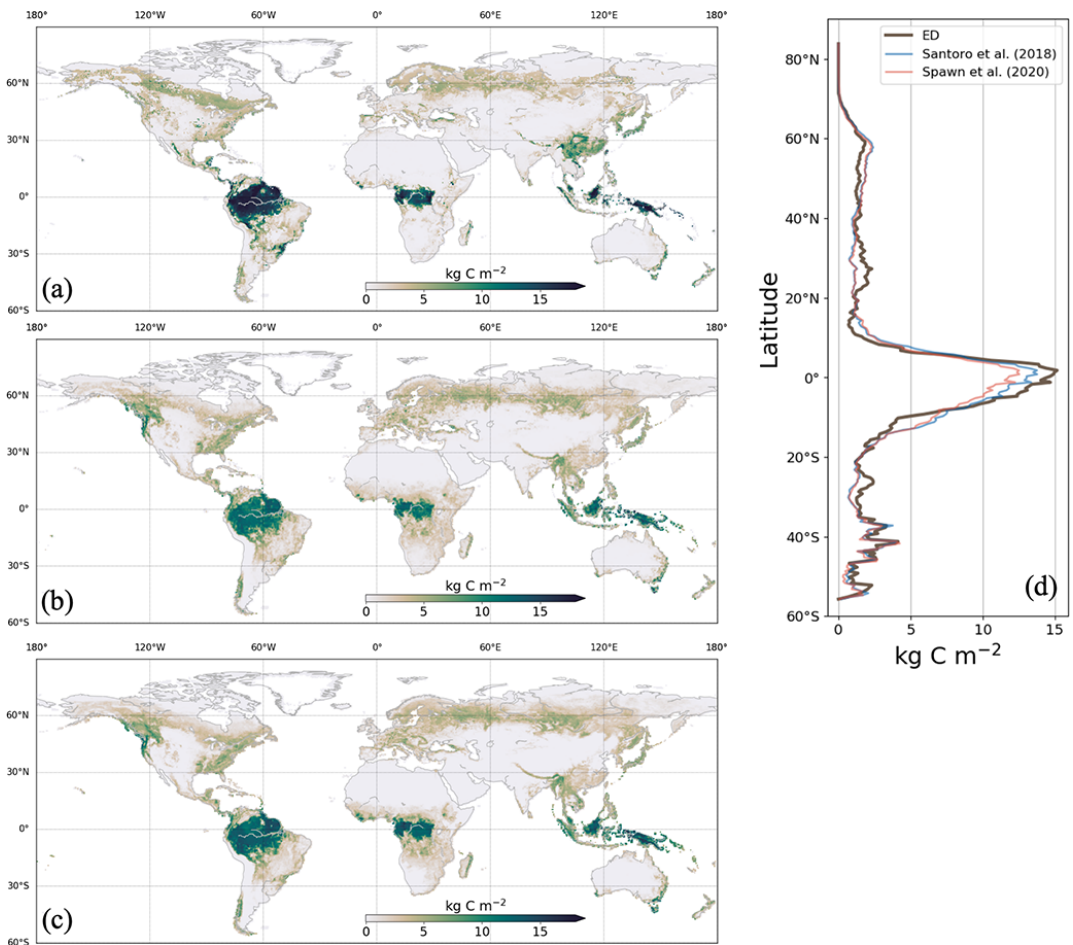
Figure 4. AGB in 2010 from ED (a) , Spawn et al. (2020) (b) and Santoro et al. (2018) (c) , with the latitudinal average AGBs compared in (d)